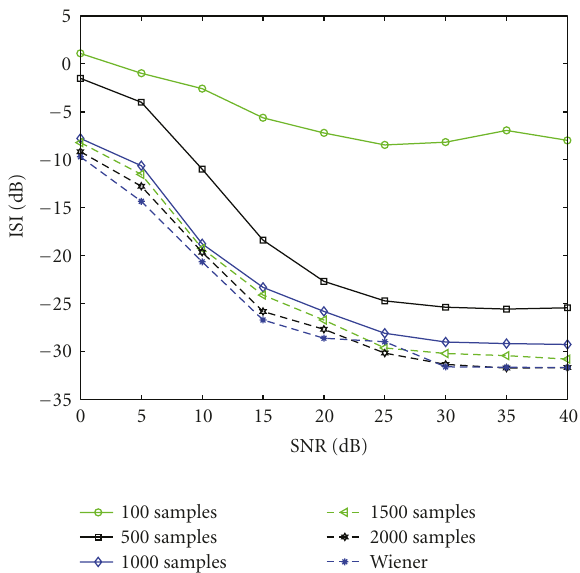
Figure 5: The proposed algorithm ISI performance for di ff erent sample sequence lengths and SNRs.